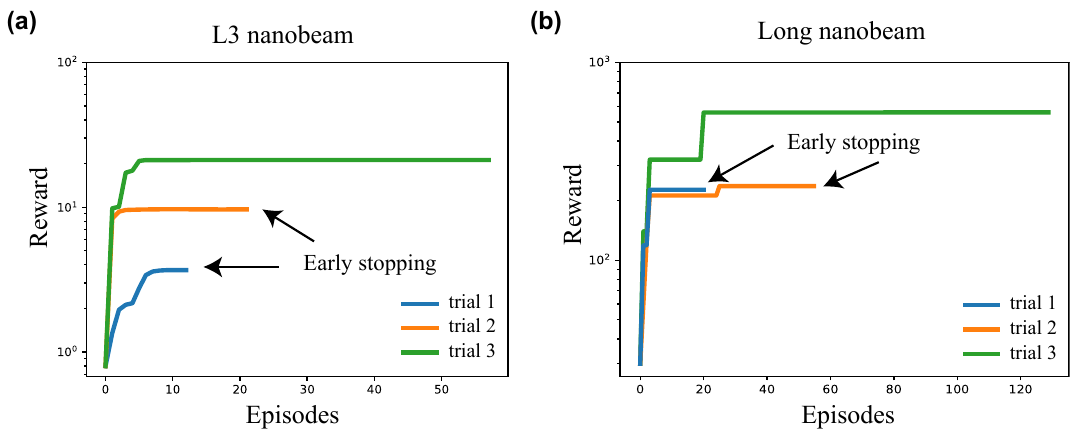
Figure 4: Learning curves of L2DO, plotted as rewards versus episodes. Vertical axes are in log-scale. (a) Convergence trends of the L3 nanobeam trained with L2DO. Trial 1 and 2 were terminated earlier because the reward stopped growing for over 50 consecutive steps. Trial 3 represents the optimal learning curve trained for 58 episodes. (b) Convergence trends of the long nanobeam trained with L2DO-DSA, where trial 3 represents the optimal learning curve trained for 131 episodes. Early stopping is utilized as well. Choice of DSA for either the L3 or the long nanobeam is explained in the Supporting Information.